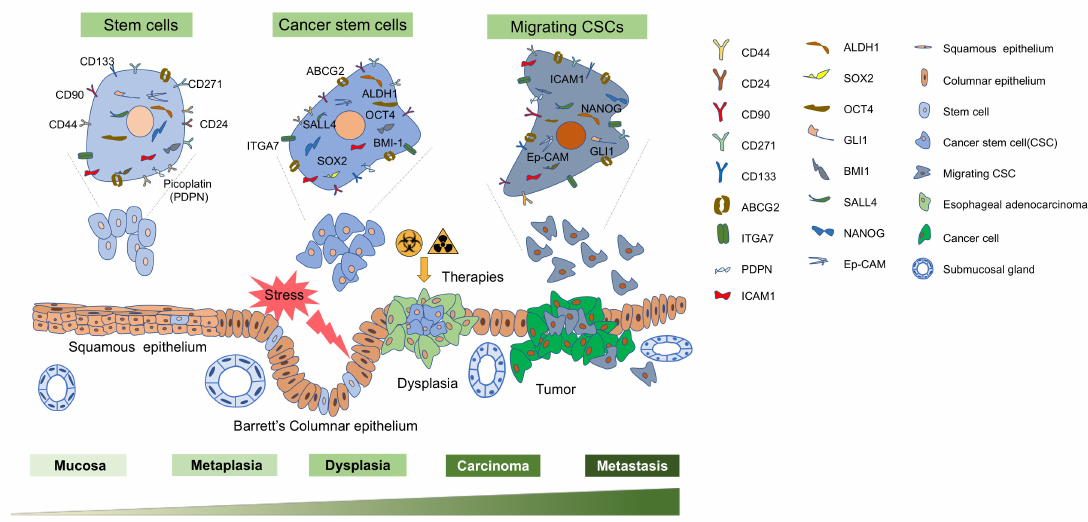
Figure 1. A schematic of various esophageal cancer stem cell markers and the overview of the progression from normal squamous epithelium to dysplastic cell and finally developing into adenocarcinoma. Cell surface markers CD44, CD24, CD90, CD271, CD133, ABCG2, ITGA7, ICAM-1 and PDPN are used as single markers while CD44 and CD133 can be used in combination with other markers, including CD24, CD133 and CXCR4 to identify cancer stem cells (CSCs). Others are the transcription factors BMI1, NANOG, SOX2, OCT-4, GLI-1, SALL4, and Ep-CAM are implicated to enrich the CSCs. Various cell types have been proposed to give rise to metaplasia (the replacement of esophageal squamous epithelium by Barrett’s columnar epithelium in response to esophageal injury) which can progress to esophageal adenocarcinoma. Esophageal cancer cells are heterogeneous and include cancer stem cell populations. Chemotherapy and / or radiotherapy kill di ff erentiated cancer cells but may fail to kill CSCs, which arise from stem cells, progenitor cells, or di ff erentiated cells. Migrating cancer stem cells are considered to have a crucial role in initiating cancer